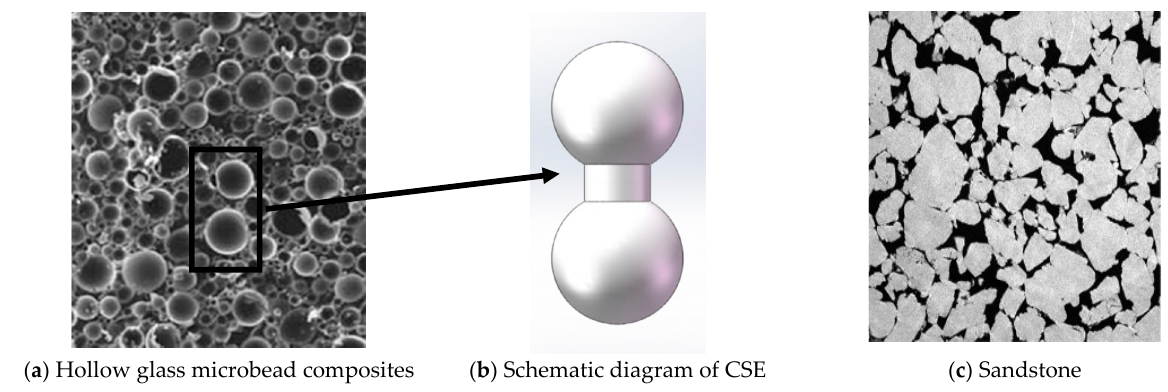
Figure 1. The meso-structure of cemented particulate composite.